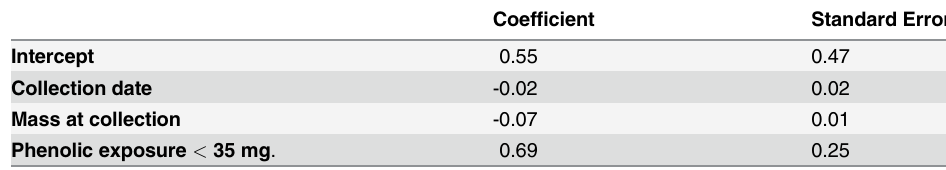
Table 2. Binomial generalized linear model of the effects of early developmental mortality ( < 35 mg) as a function of exposure to a cluster of phenolic